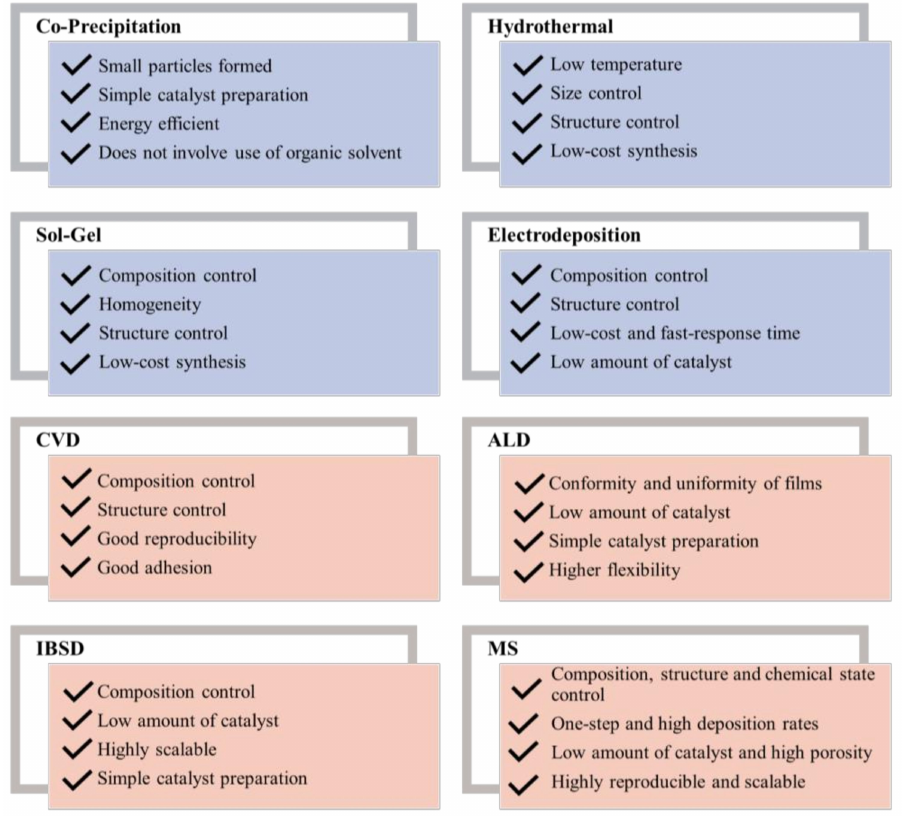
Figure 8. Summary of the main advantages of the catalyst deposition processes regarding their implementation in